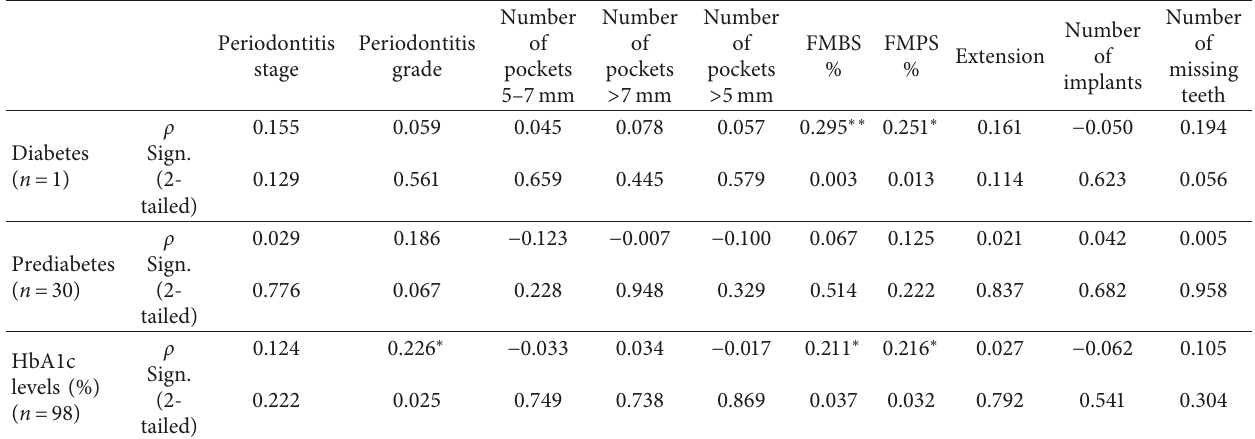
Table 2: Correlations between diabetes parameters and periodontal